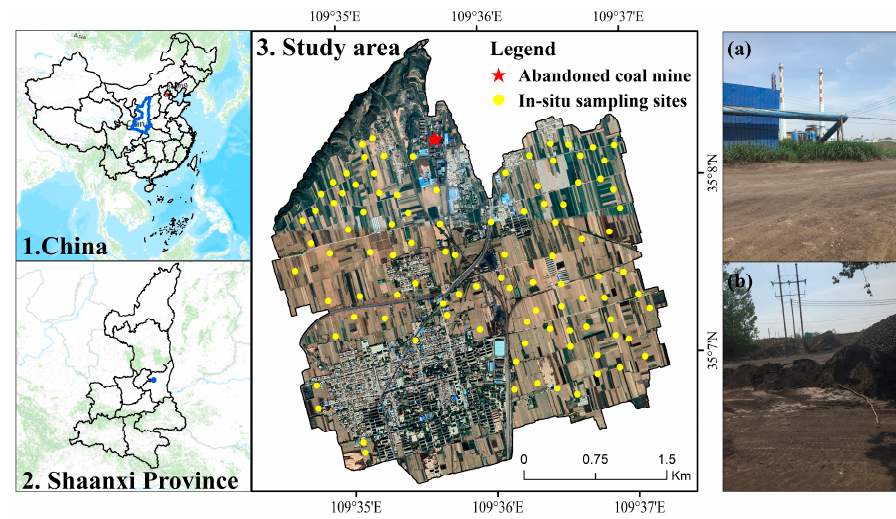
Figure 2. Location of the study area and in-situ sampling sites. ( a ): An abandoned cement factory, ( b ): An empty field heaped with cinders.